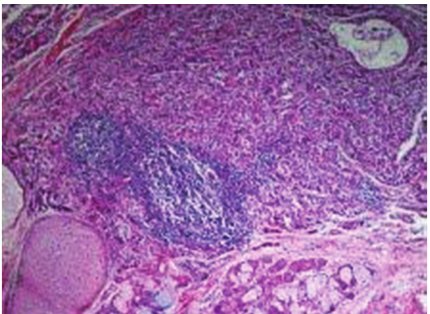
Figure 1: A carcinoid tumor is seen in the upper half of the picture. An island of mature hyaline cartilage (lower left), and lobules of mucous and serous glands (lower part towards the center) are also seen (H&E, × 100).